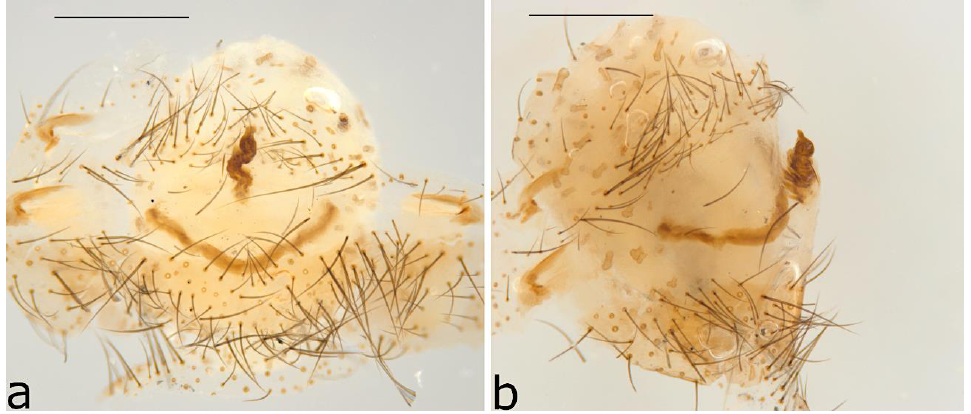
Figure 16. Ariadna sinuosa sp. nov. ♀ (MV K-4990a) from Archeron Gap (Vic): anterior receptaculum ( a ) ventral view; ( b ) same, lateral view. Scale bar = 0.5 mm. Ariadna formosa species group Diagnosis. No apophyses on metatarsus I of males. Retrolateral preening comb of tarsus IV consisting of three macrosetae. Overall dark colouration, with dark brown ceph- alothorax, dark grey abdomen.